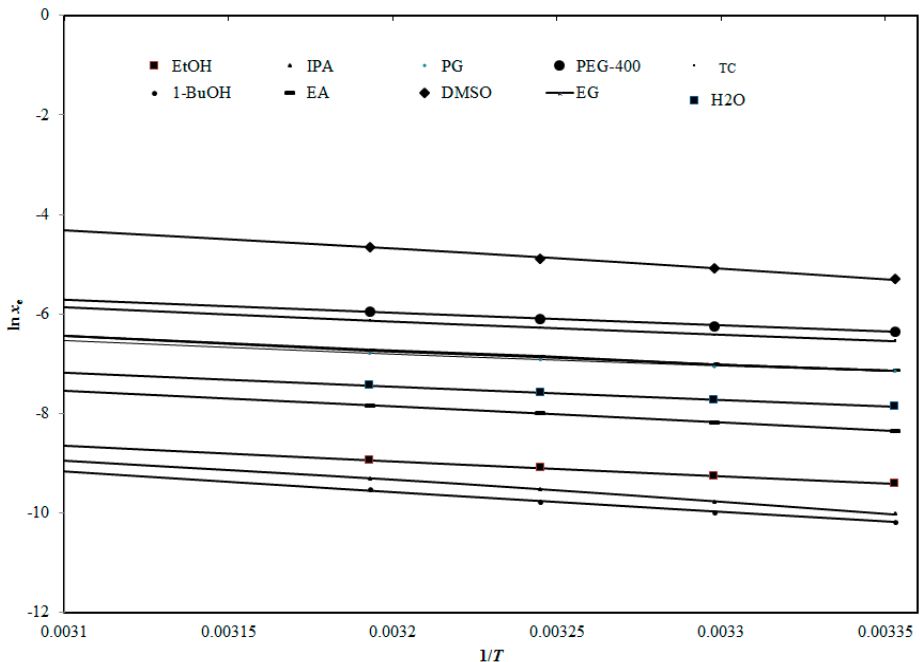
Figure 4. Correlation of ln x e values of TMZ with “Apelblat model” in every solvent examined in the current study as a function of 1/ T ; symbols represent the experimental solubilities of TMZ and solid lines represent the solubilities of TMZ estimated by “Apelblat model”.